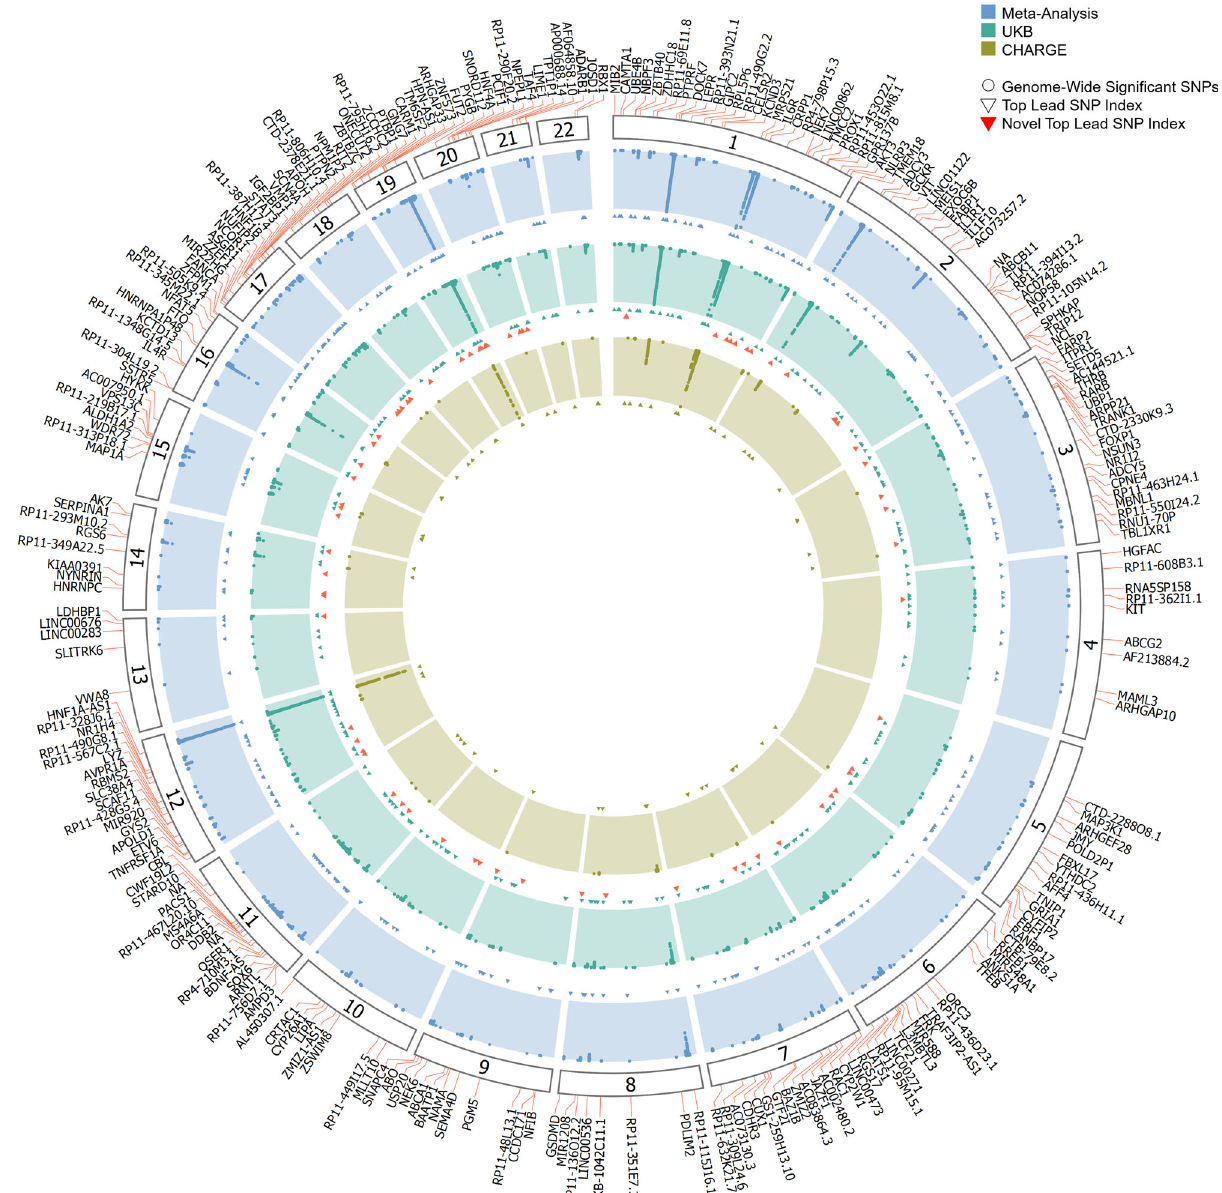
Fig. 2 Circle Manhattan plot. Genome wide signi fi cant hits at p < 5 × 10 − 8 are presented for CHARGE CRP meta-GWAS (inner circle), UKB CRP GWAS (middle circle) and meta-analysis of UKB-CHARGE (outer circle). Labelled genes are the sentinel SNPs of each 266 loci nearest